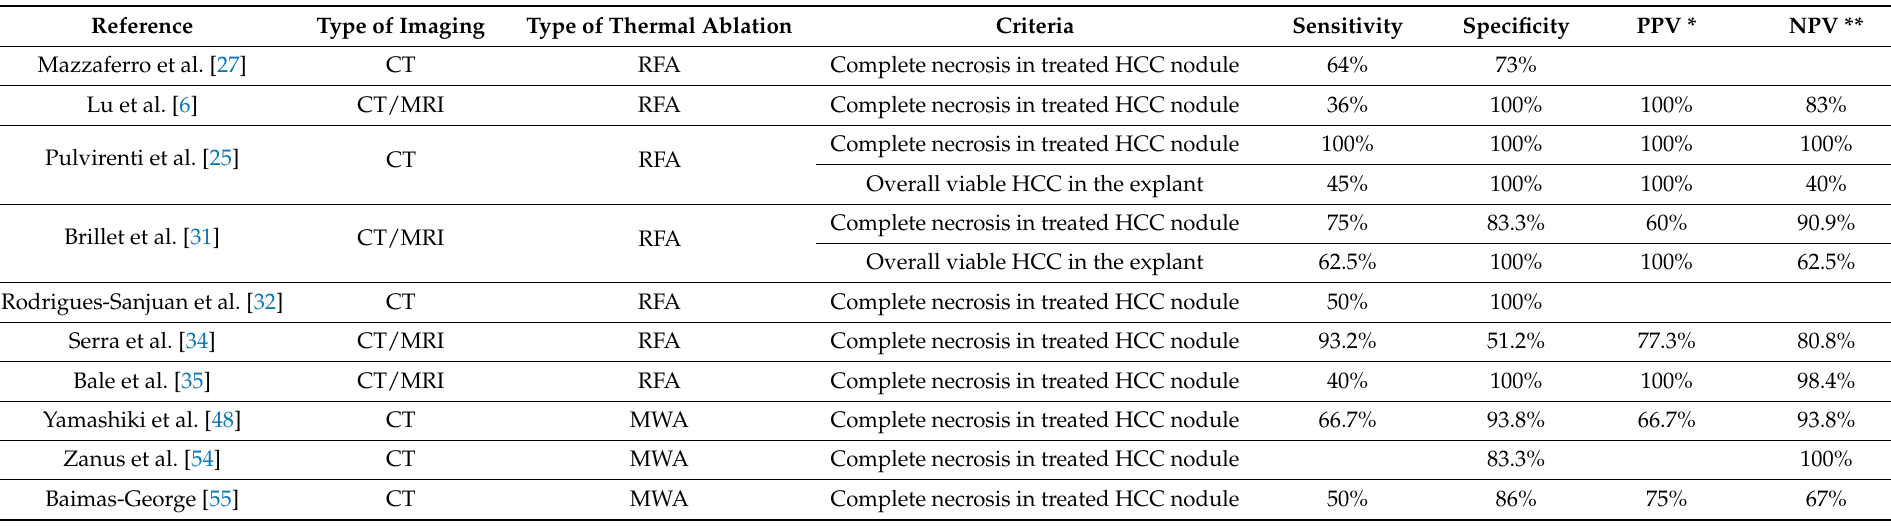
Table 3. Cross-sectional imaging correlation with histopathological findings in liver explants after RFA or